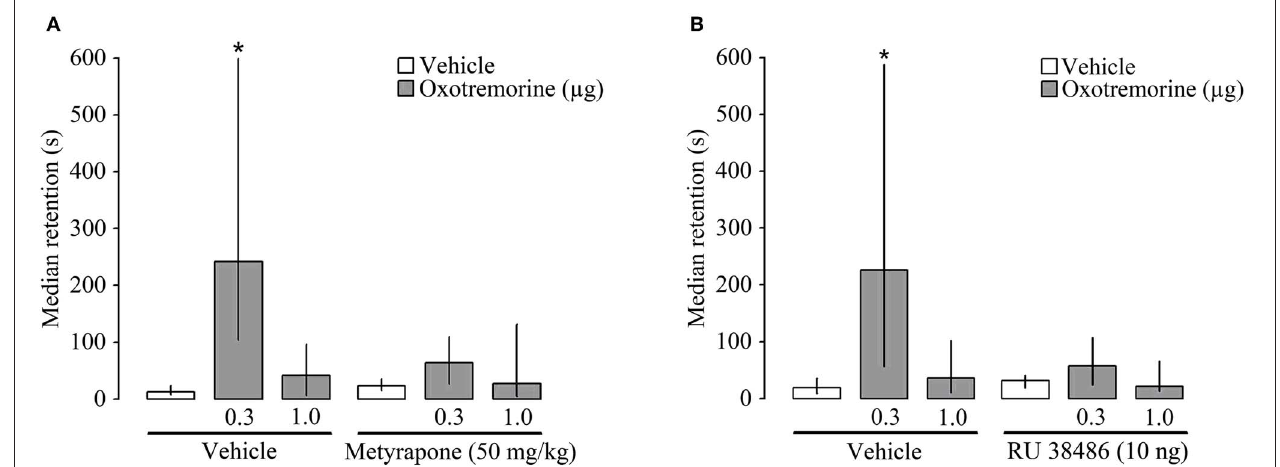
FIGURE 3 | Median latencies and interquartile ranges, in seconds on the 48h inhibitory avoidance retention test. (A) Post-training infusion of the muscarinic receptor agonist oxotremorine (0.3 μ g) into the dorsal striatum enhanced 48h retention performance and a pre-training systemic administration of the 11 β -hydroxylase inhibitor metyrapone (50mg/kg)